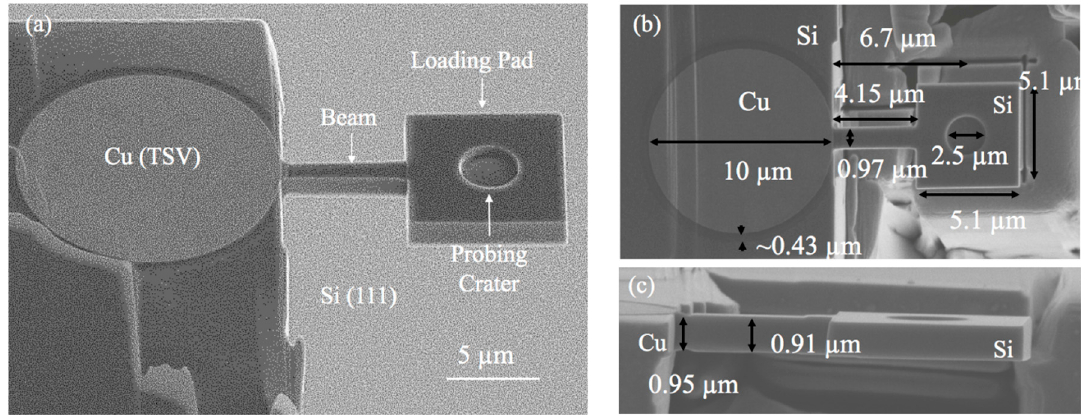
Figure 2. Micro-cantilever beam specimens: ( a ) Isometric view and structural components, ( b ) top view, and ( c ) side view with dimensional details ( L = 4 µm).